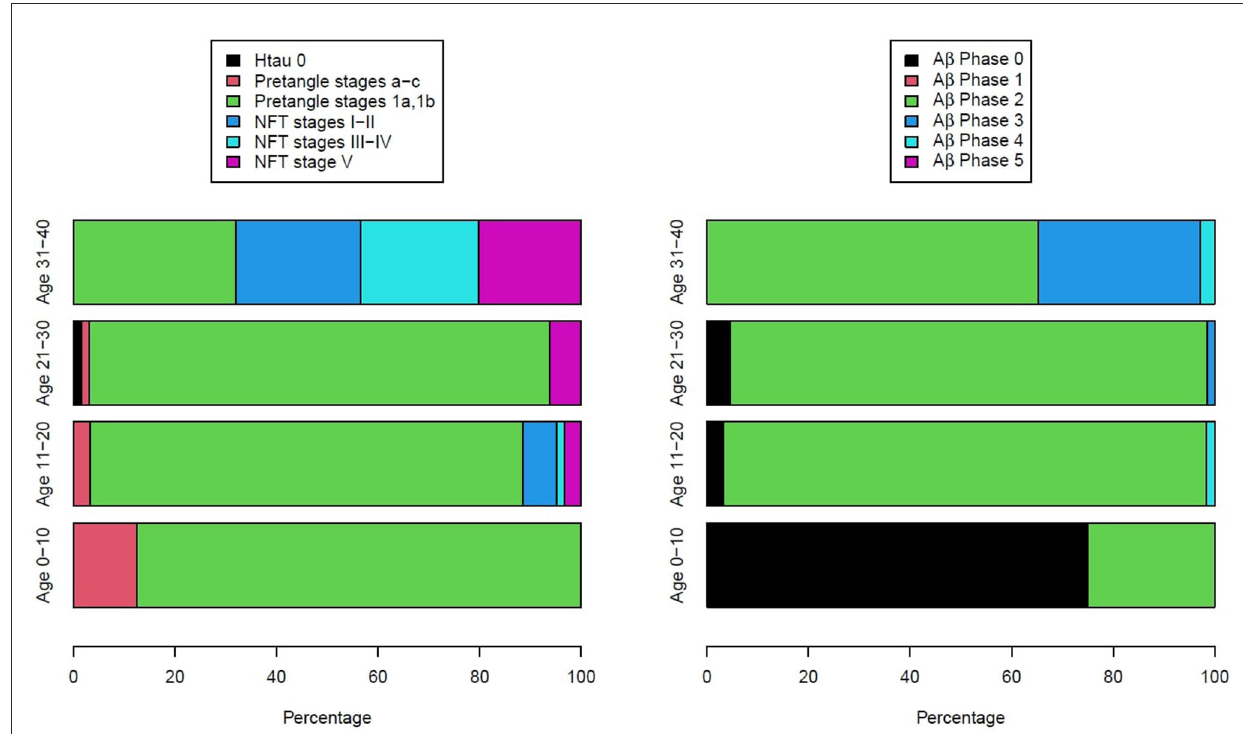
FIGURE3 Two hundred and three forensic autopsies were staged for Alzheimer’s disease using p-tau and A β 1 − 42 (9). Subjects were 25.4 ± 9.2 years old and causes of death were related to car accidents, homicides, and suicides; 202/203 had AD pathology, including the youngest subject, an 11-month-old baby.